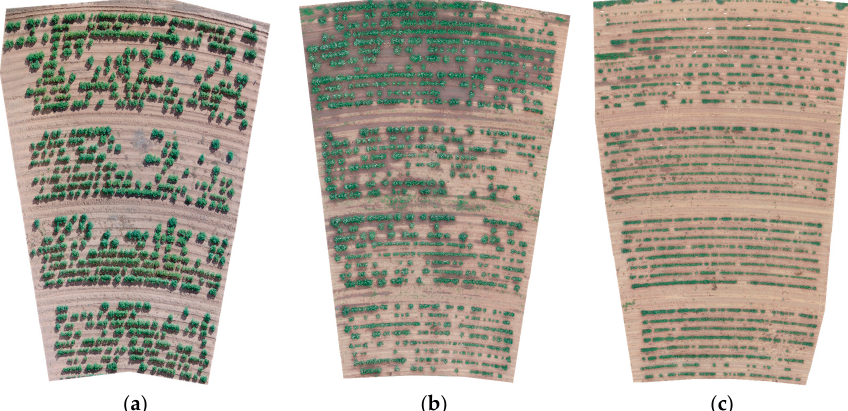
Figure 2. Red, green, and blue (RGB) orthomap image of three cotton plots. Images were acquired near the end of the growing season and show the maximum extent of canopy area. Panel ( a ), plot 1, was planted on March 15, 2018 and imaged 153 days after planting (DAP). Panel ( b ), plot 2, was planted on April 12, 2018 and imaged 147 DAP. Panel ( c ), plot 3, was planted on May 29, 2018 and imaged 100 DAP.3.3. Maximum Canopy Size and Analysis.